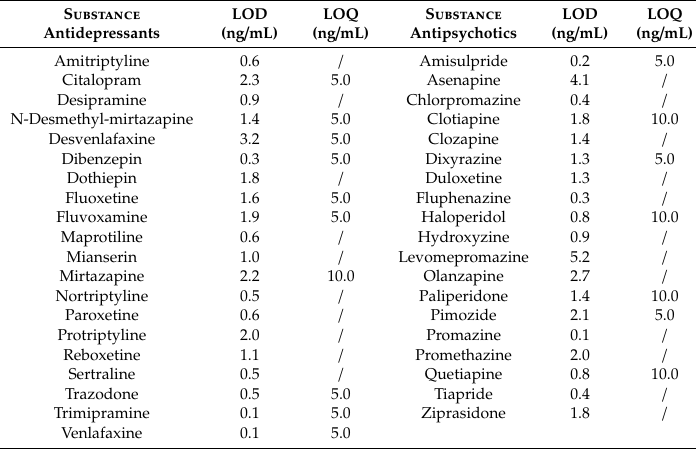
Table 1. Limits of detection (LODs) and quantification (LOQs).